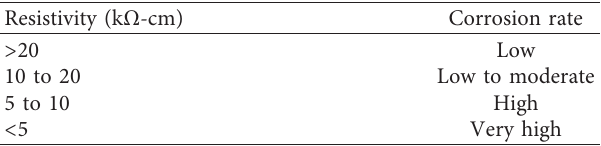
Figure 11: Carbonation depth of concrete mixes for an exposure period of 4 weeks. Table 3: Relationship between concrete resistivity and corrosion rate (ACI 222R-01 2001)